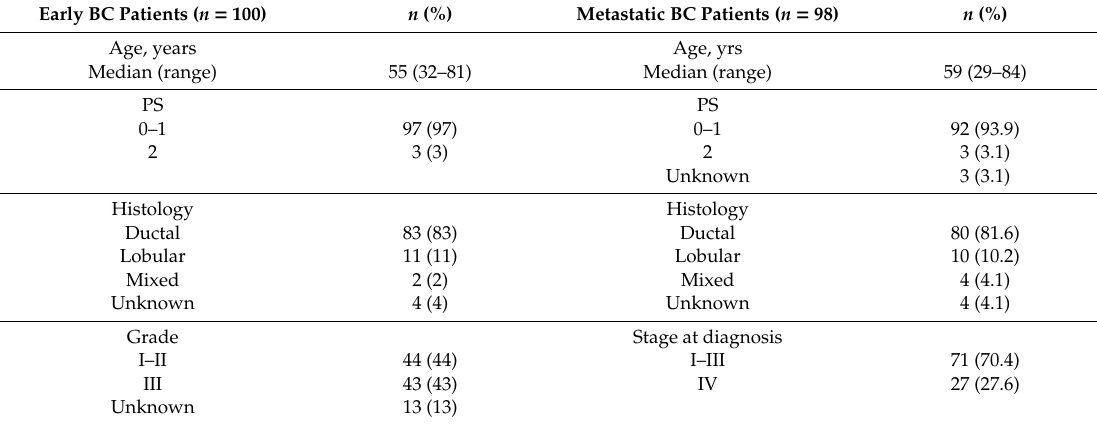
Table 1. Patient and disease characteristics of patients with early and metastatic breast cancer (BC). Early BC Patients ( n =